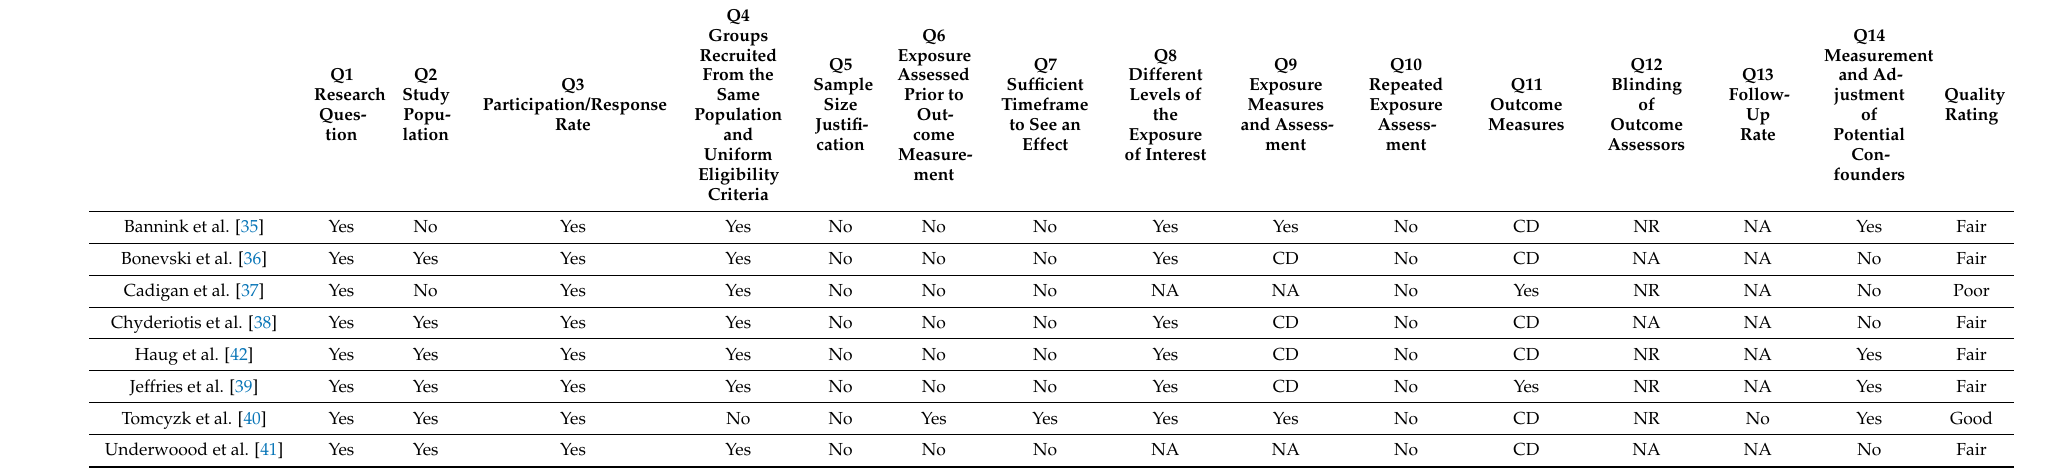
Table 3. Methodological quality assessment of eligible